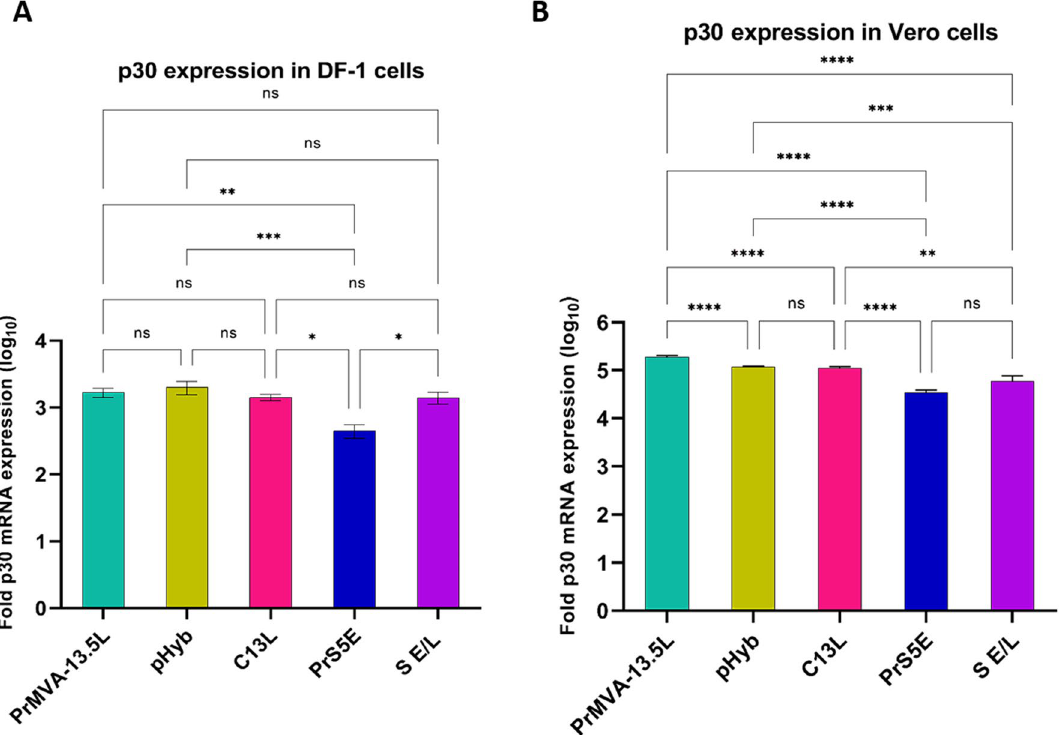
Figure 2. Expression levels of p30 were analyzed at the mRNA level. DF-1 and Vero cells were infected with the indicated MVA-p30 virus, and after 24 h, total RNA was isolated and reverse transcribed. ( A ) indicates mRNAs from DF-1 cells and ( B ) from Vero cells. Fold p30 expression levels were calculated relative to the cells infected with MVA-GFP control and after normalization to the β-actin gene. Sample reactions, including MVA-GFP, were performed in triplicate and two independent repetitions. Statistically significant differences between MVA-p30 viruses are shown (P < 0.05, one-way ANOVA with Tukey’s multiple comparison test). For DF-1 cells: *P < 0.01; **P < 0.002; ***P < 0.0003. For Vero cells: **P < 0.0012; ***P < 0.0004; *****P < 0.0001.